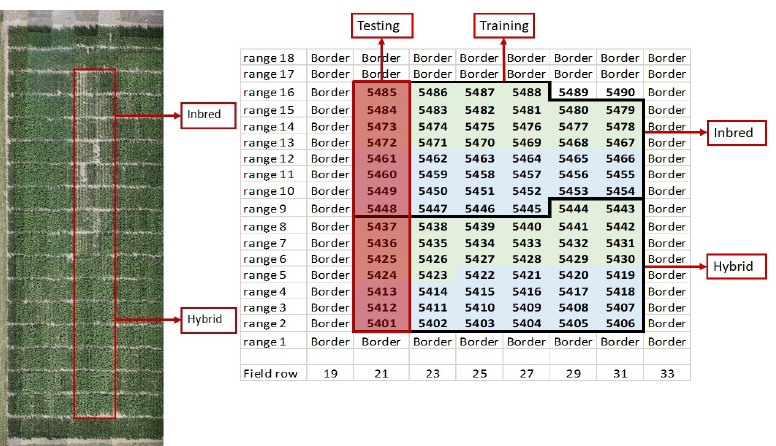
Figure 11. RGB image of the field and experiment layout. The training and testing regions were selected to include inbred and hybrid